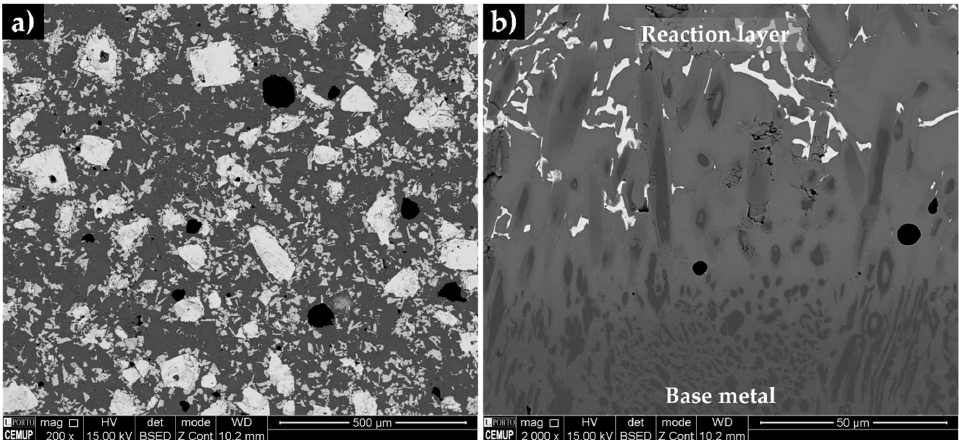
Figure 14. SEM-BSE image of the microstructure of the composite zone, showing a uniform distribution of the carbide particles ( a ) and the reaction layer, evidencing a bonding interface free of discontinuities ( b ).